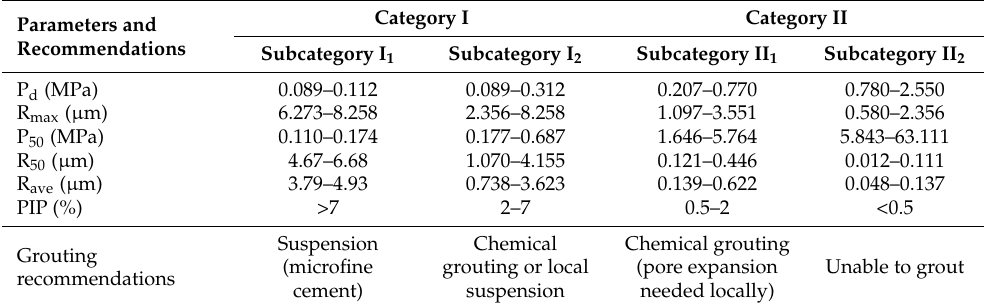
Table 10. Parameters and recommendations for different sandstone